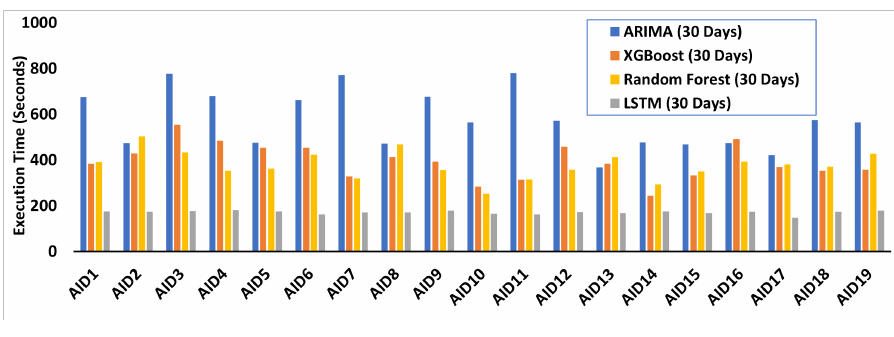
Figure 3. MAE, RMSE, and execution time from ML/DL models employing 30 days of training